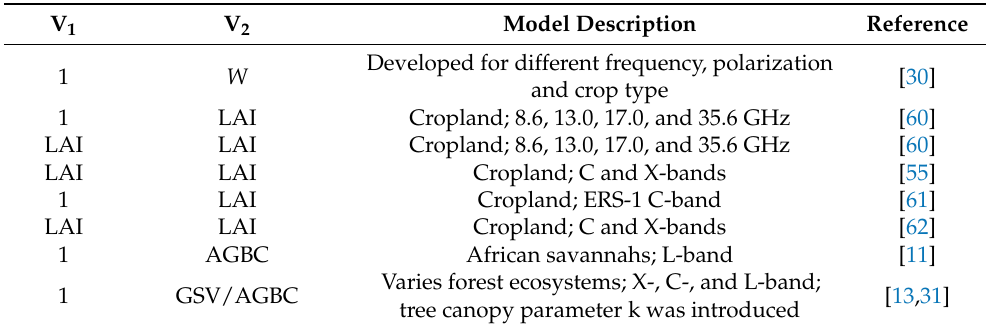
Table 2. Remote-sensing-based index for vegetation descriptors used in the WCM from the literature. V 1 and V 2 are vegetation descriptors [55], W is the volumetric water content of the vegetation layer [30], LAI is the leaf area index [58], and GSV is the growing stock volume [59]. V 1 V 2 Model Description Reference Developed for different frequency, polarization 1 W and crop type LAI Cropland; 8.6, 13.0, 17.0, and 35.6 GHz LAI LAI Cropland; 8.6, 13.0, 17.0, and 35.6 GHz LAI Cropland; C and X-bands Cropland; ERS-1 C-band Cropland; C and X-bands African savannahs; L-band Varies forest ecosystems; X-, C-, and L-band; tree canopy parameter k was